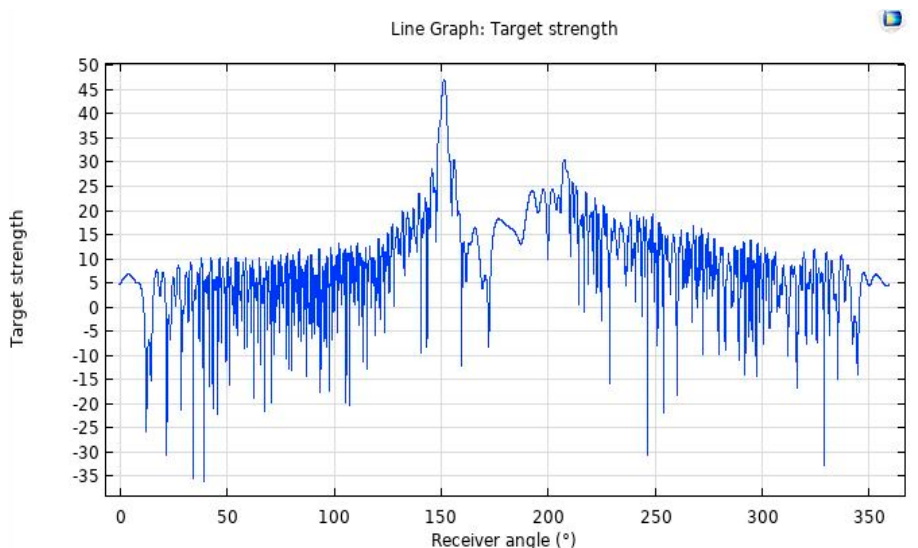
Figure 8. The polar plot of the sound pressure.